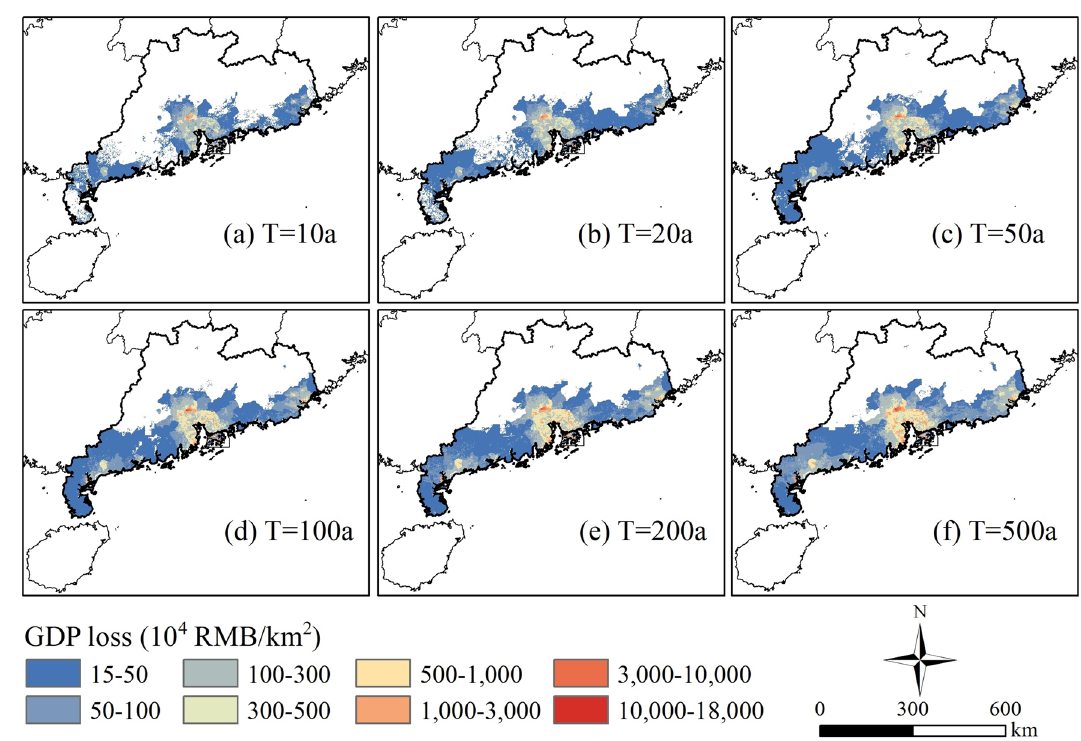
Fig. 9 Spatiotemporal distribution of direct economic (GDP) loss caused by tropical cyclones in six return periods in Guangdong Province, South